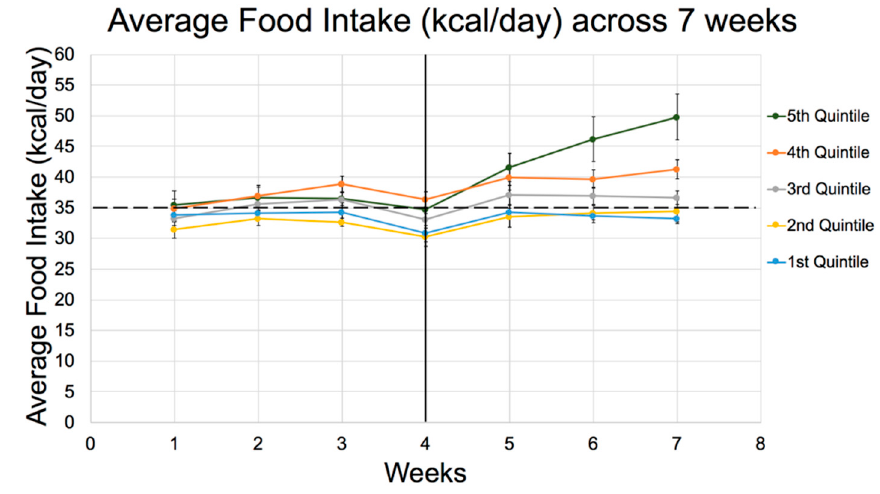
Figure 2. Average Food Intake (kcal/day) for 7weeks on Diet 73 (70:10:20, CHO:fat:protein % energy) by quintiles in Experiment 3. Dotted line represents the average food intake threshold per day (35 kcal/day), exceeded only by Q4 and Q5. The dip in food intake at 4 weeks reflects the stress as a result of OGTT conducted that week. See Table 5 for detailed differences between quintiles apparent from week 1.